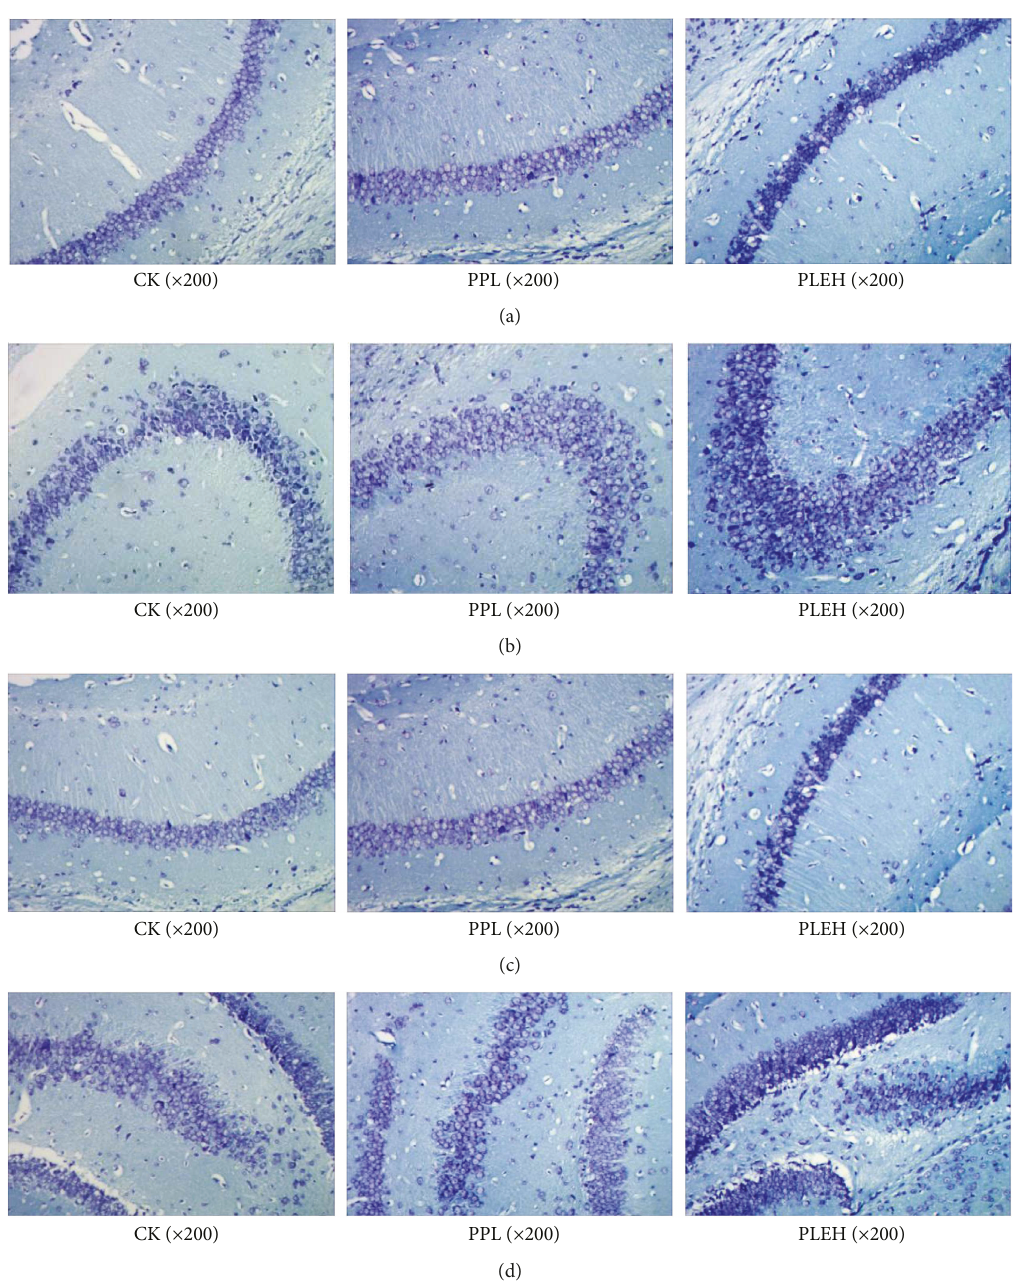
Figure 11: (a) Situation of Nissl body staining in CA1 district of cubs ’ hippocampi. (b) Situation of Nissl body staining in CA2 district of cubs ’ hippocampi. (c) Situation of Nissl body staining in CA3 district of cubs ’ hippocampi. (d) Situation of Nissl body staining in DG district of cubs ’